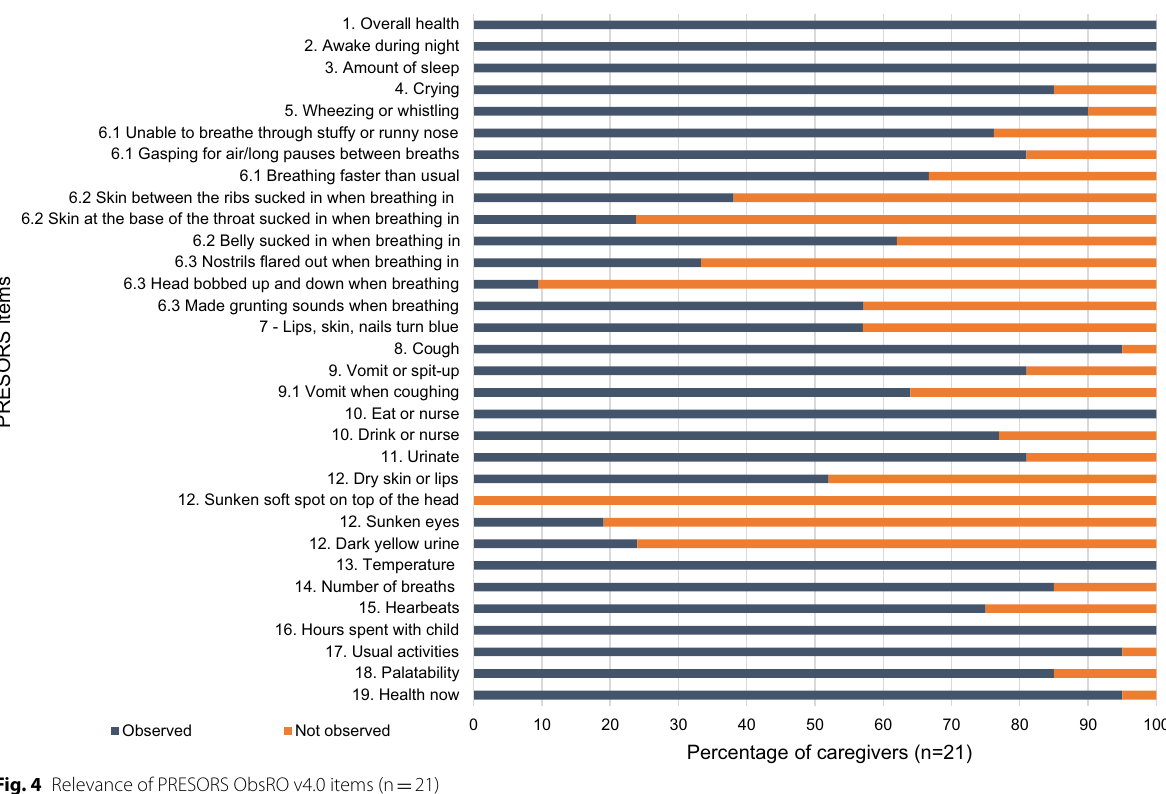
Fig. 4 Relevance of PRESORS ObsRO v4.0 items (n